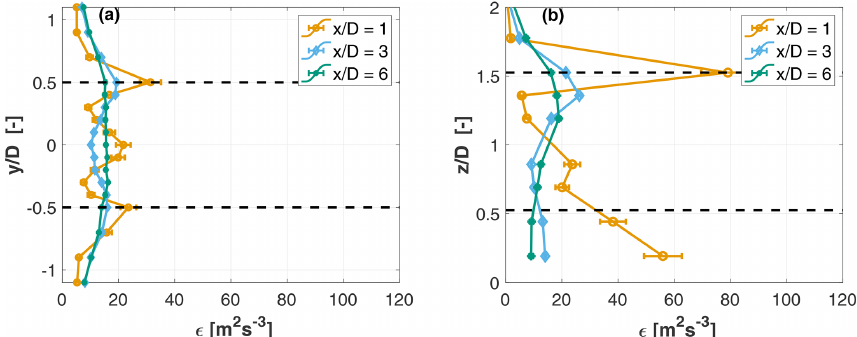
Figure 23. Horizontal (a) and vertical (b) profiles of the dissipation rate (cid:15) κ at several downstream distances, for TUM-HT inflow conditions. Black dashed lines indicate the rotor